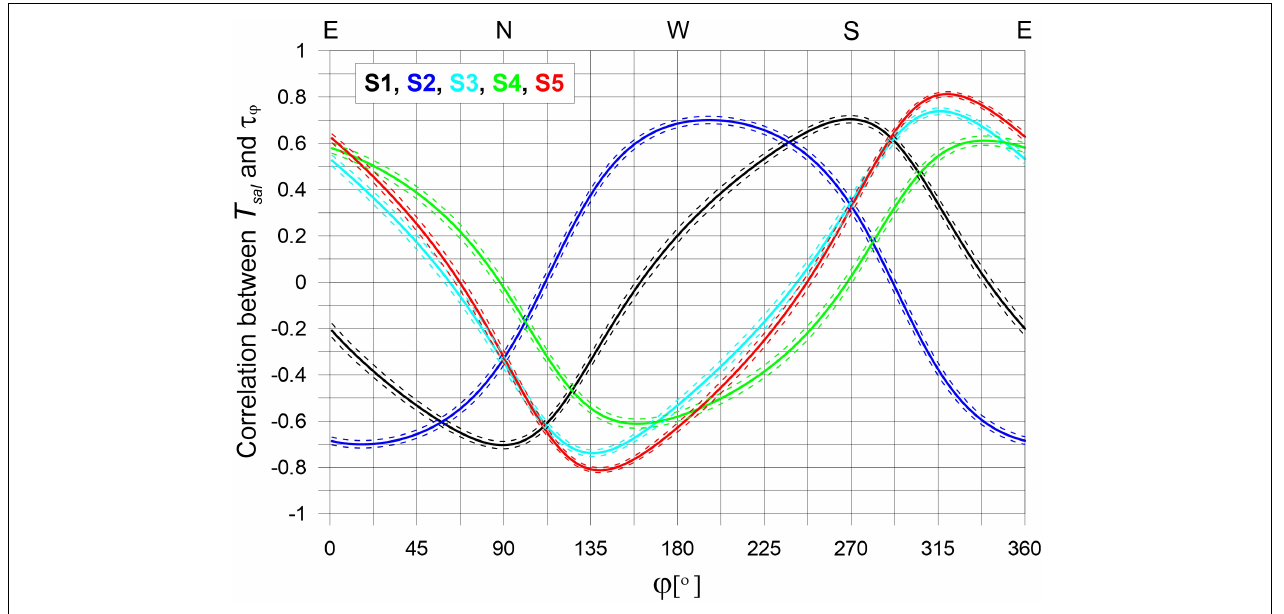
FIGURE 6 | Correlation between the daily saltwater transport T sal through cross-sections S1–S5 and the projection of the wind stress vector τ ϕ = (cid:104) τ x (cid:105) cos ( ϕ ) + (cid:104) τ y (cid:105) sin ( ϕ ) vs. angle ϕ . The dotted lines are the 95% confidence limits.